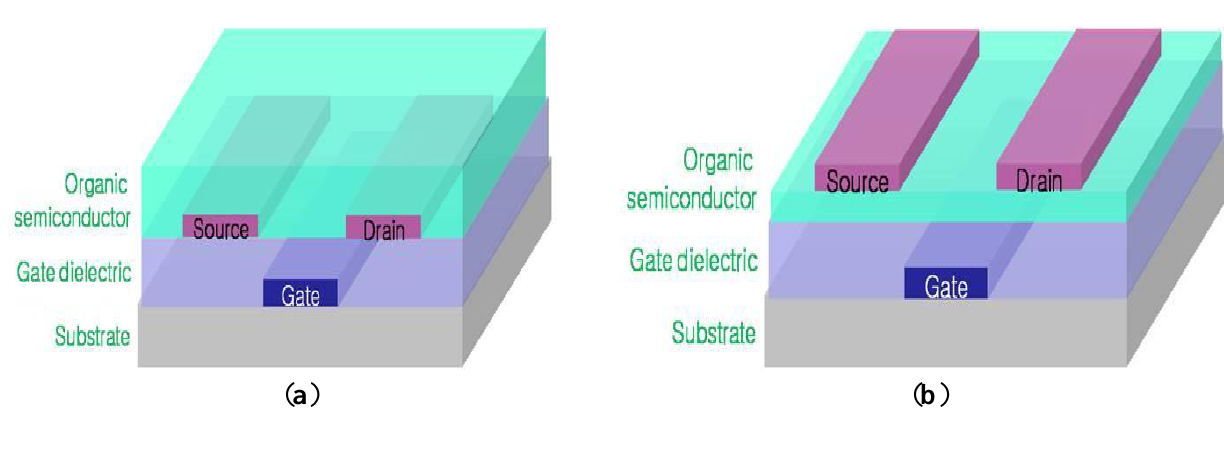
Figure 2. Schematic cross section of OTFT structures. ( a ) Bottom-contact and ( b ) Top-contact